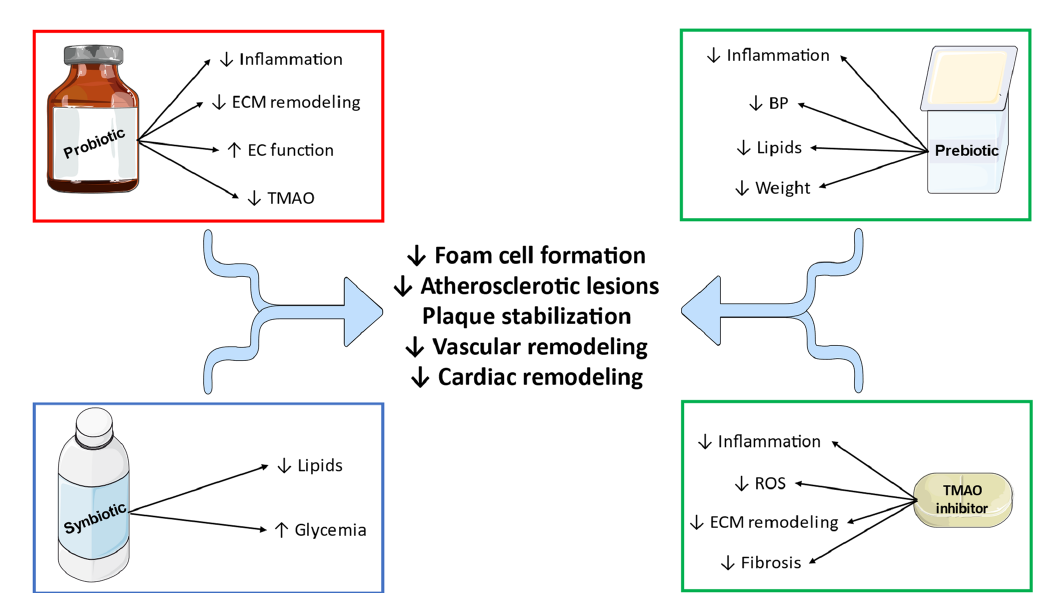
Figure 2. Beneficial effects of gut microbiota modulators in coronary artery disease. ECM: extracellular matrix, EC: endothelial cell, TMAO: trimethylamine N-oxide, BP: blood pressure, ROS: reactive oxygen species. ↓ : decreased, ↑ increased.